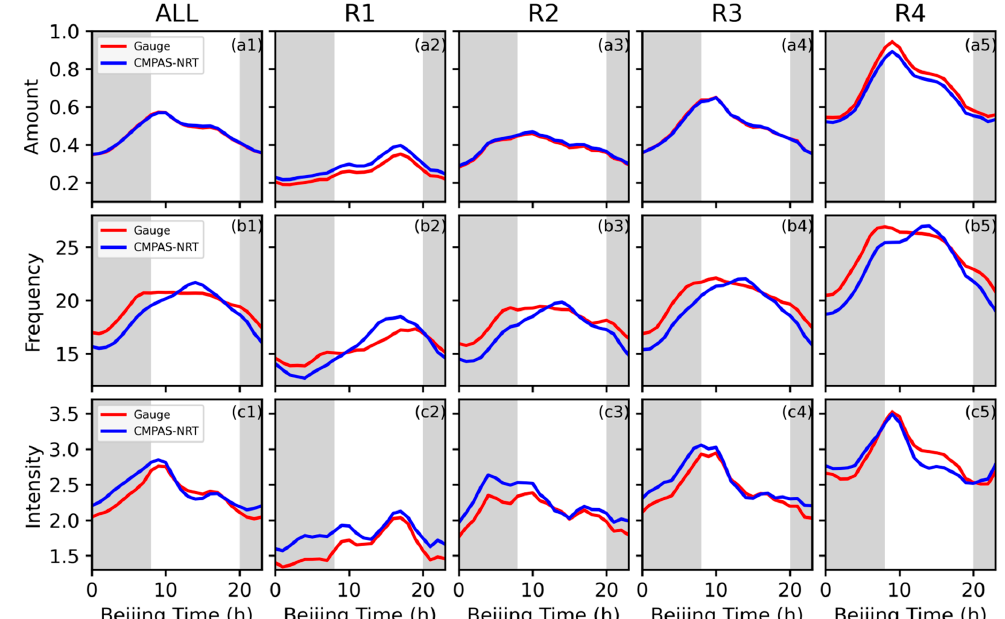
Figure 14. Comparative analysis of the daily variation in precipitation (mm/h), precipitation frequency (%), and precipitation intensity (mm/h) between surface rain-gauge observations (Gauge, red) and the CMPAS-NRT product (blue) in the rainfall monitoring area (including each sub-region and the whole area) during the 2020 Meiyu period, with the gray shaded area at night (20:00–08:00 Beijing time). Panels ( a1 – a5 ) are the precipitation amounts, ( b1 – b5 ) are the precipitation frequencies, and ( c1 – c5 ) are the precipitation intensities.